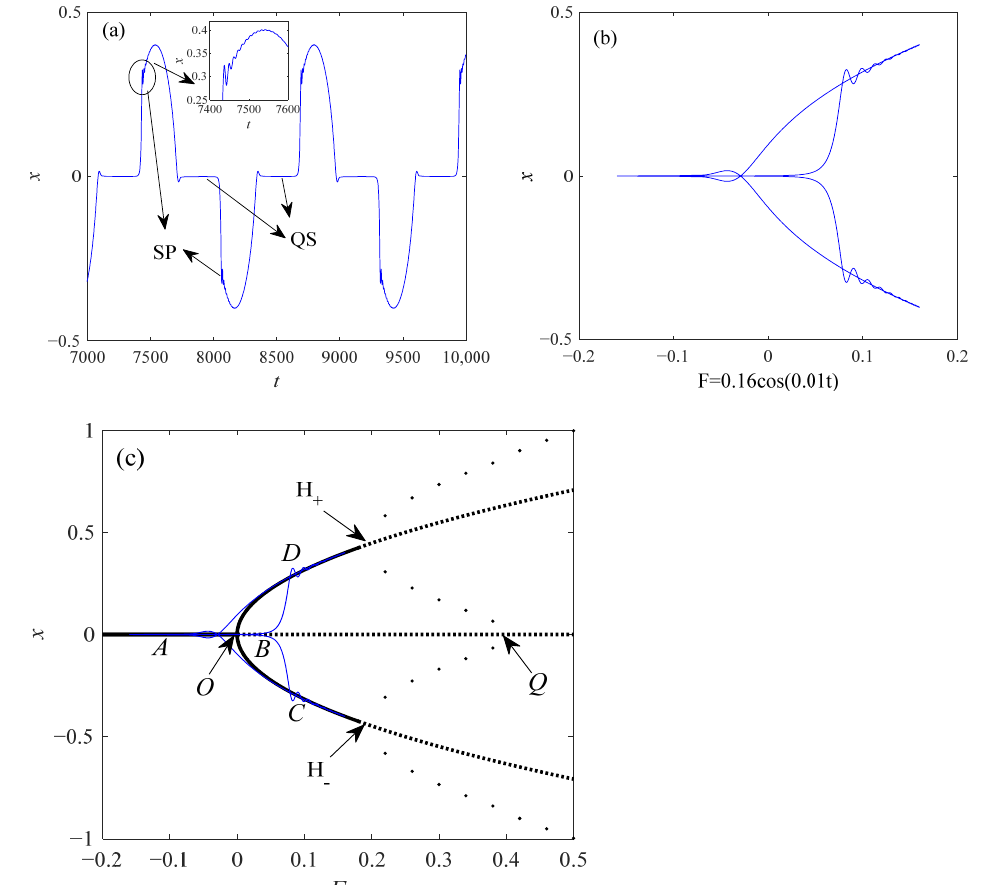
Figure 8. Cluster oscillation with β = 0.16. ( a ) Time history diagram. ( b ) Transition phase diagram for